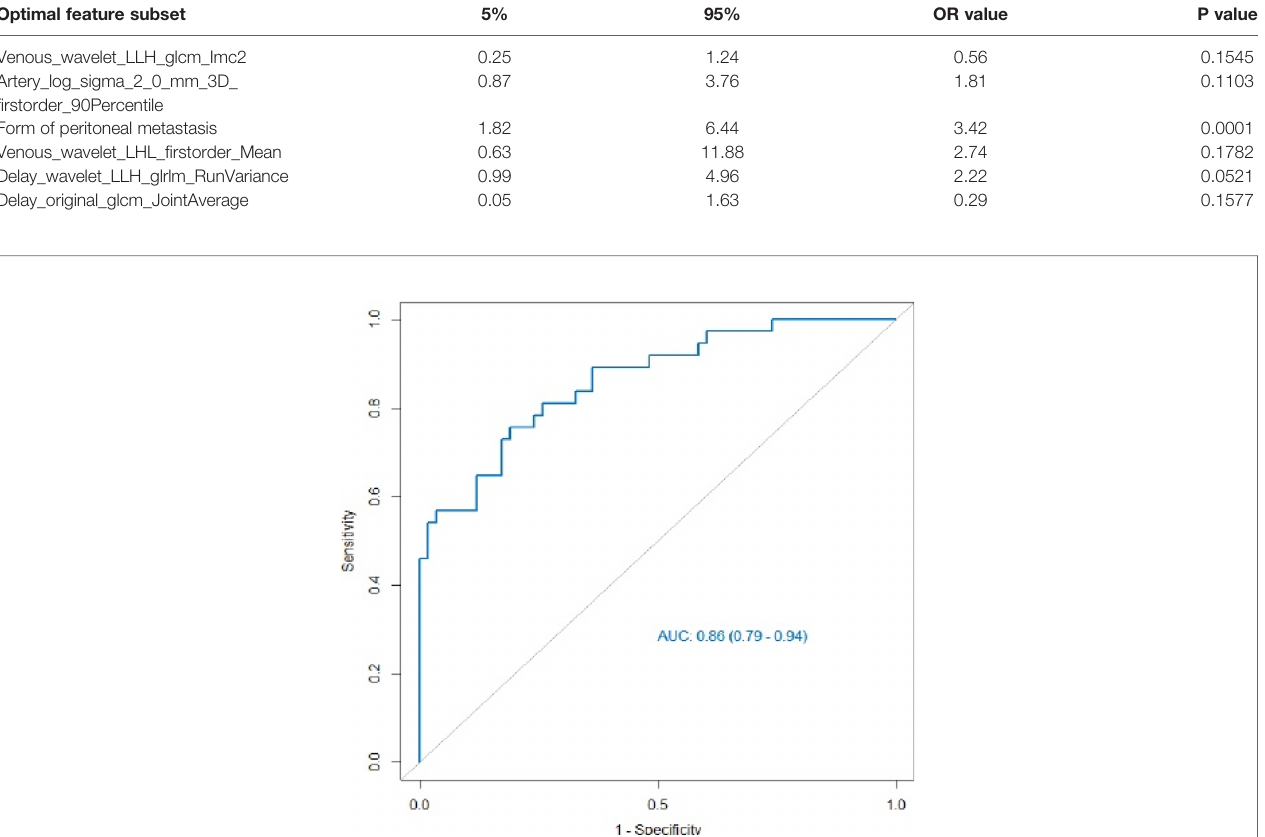
FIGURE 5 | ROC curve of the integrated model. Its AUC value was 0.86 (95% CI 0.79 – 0.94), and its prediction performance was signi fi cantly improved compared with that of the single feature.